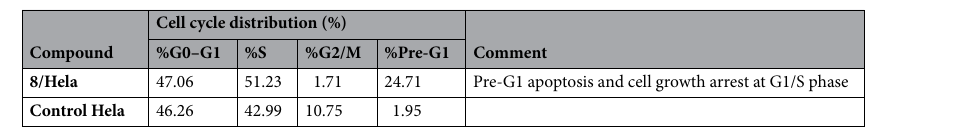
Table 4. Effect of compound 8 on the cell cycle phases in MCF-7 cells.